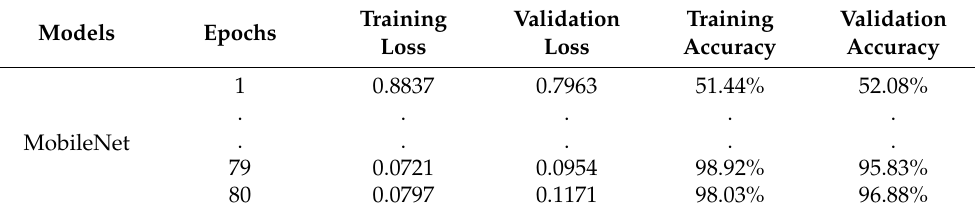
Table 4. Training performance of the CNN models used in this